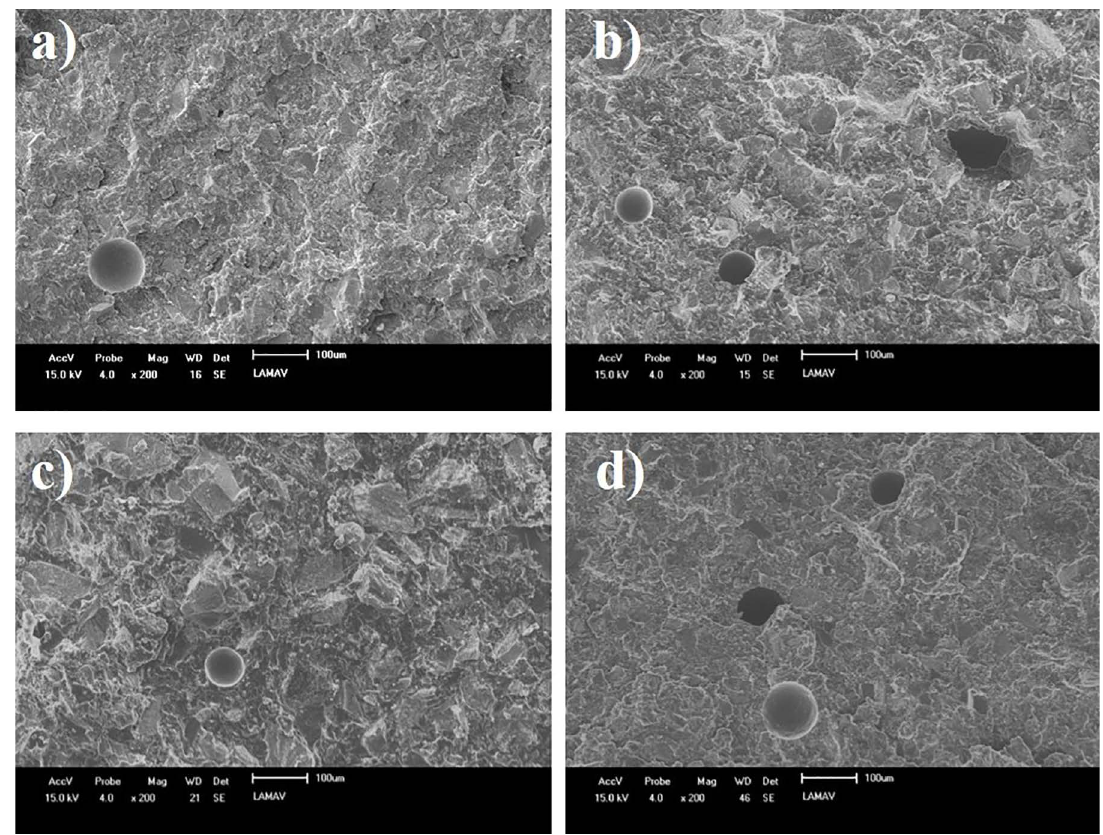
Figure 6. SEM micrographs of the artificial rocks produced with chicken eggshell waste (< 150 mesh): a) 50/50; b) 55/45; c) 60/40; and d) 65/35.